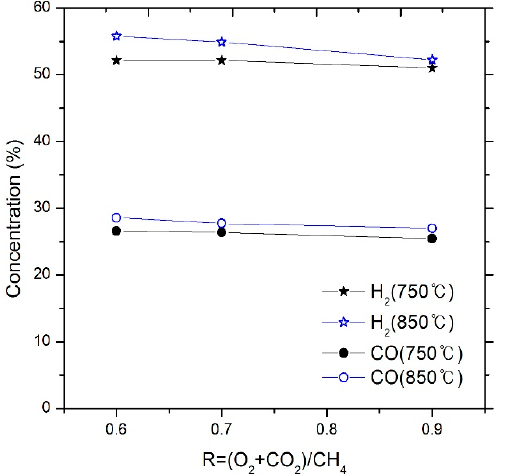
Figure 12. Effect of R = ((O 2 + CO 2 )/CH 4 ) values on H 2 and CO formation with steam addition.